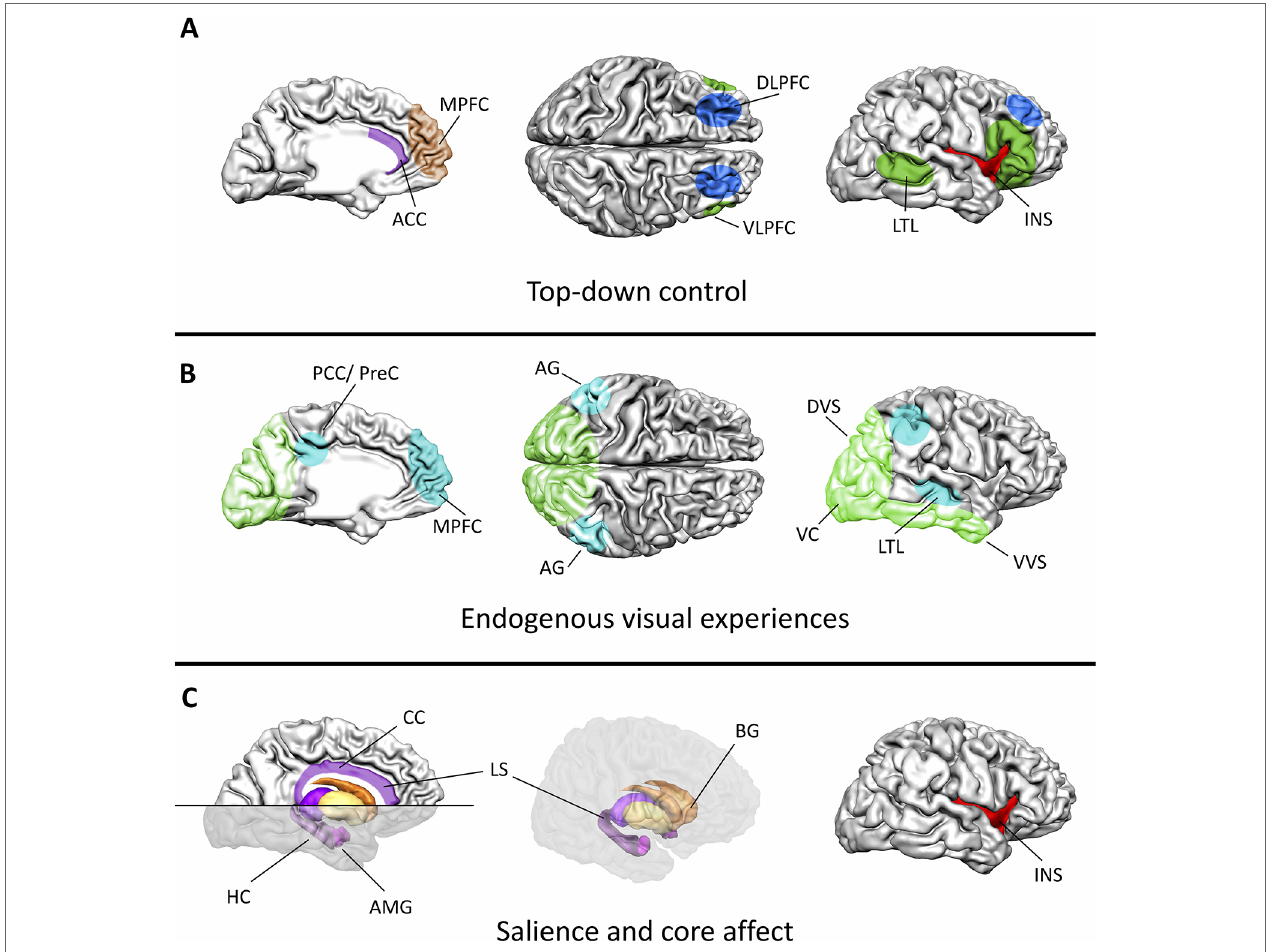
FIGURe 1 | Major functional components and associated brain systems of mental imagery during emotion regulation. (A) Cognitive control during mental imagery treatments relies on a distributed cortical network. The dorsolateral PFC and lateral parietal cortex (blue) control mental resources, while the semantic interpretation of the internal state is associated with activation in the ventrolateral PFC and the lateral temporal cortex (dark green). The anterior cingulate cortex (ACC, purple) and the medial PFC (brown) monitor the ongoing processes. The ACC together with the insula (red) thereby function as major connecting hubs between bottom-up saliency information and top-down attentional control. (B) Visual experiences during mental imagery mimic actual perception of external stimuli in the visual system (light green). The sensory content of a mental image is thereby activated across different levels of the visual processing hierarchy, ranging from low level visual areas to associate cortices. Modulations in the default-mode-network (turquoise) indicate increased processing of the endogenously generated information. (C) Particularly, the limbic system (purple), the basal ganglia (orange/yellow), and the insula (red) encode the hedonic value, arousal, and salience of the visual experience. This information can directly affect ongoing learning processes as particularly the hippocampus is crucially involved in encoding and retrieving emotional memories. The insula, the anterior cingulate cortex, the amygdala, and the ventral basal ganglia form a network that encodes the salience of a generated experience. As a connecting hub between various systems the insula constitutes a key region for introspection during mental imagery. ACC, anterior cingulate cortex; AG, angular gyrus; AMG, amygdala; BG, basal ganglia; DLPFC, dorsolateral PFC; DVS, dorsal visual stream; HC, hippocampus; INS, insula; LS, limbic system; LTL, lateral temporal lobe; MPFC, medial PFC; PCC/PreC, posterior cingulate cortex/precuneus; VC, visual cortex; VLPFC, ventrolateral PFC; VVS, ventral visual stream; CC, cingulate